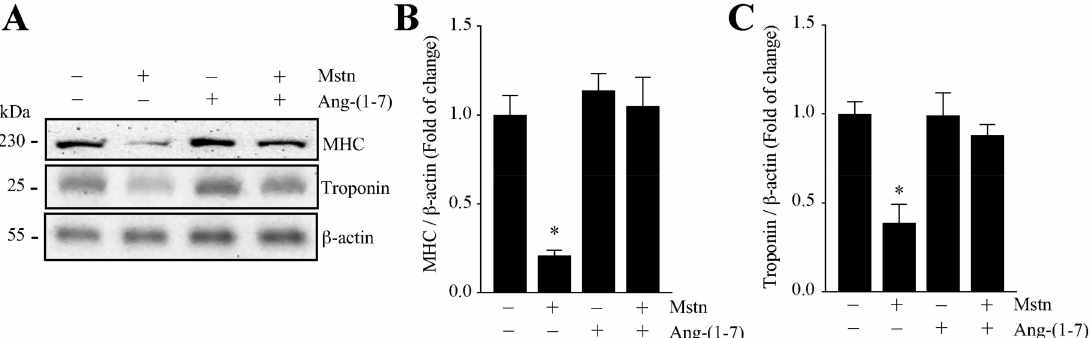
Figure 2. Ang-(1-7) decreased the myostatin-dependent decline in the myofibrillar protein levels in the myotubes. The C 2 C 12 myotubes were incubated with myostatin (Mstn, 1 µ g / mL) for 72 h in the presence or absence of Ang-(1-7) (10 nM; pre-incubated for 1 h). ( A ) The MHC, troponin, and β -actin protein levels were determined by Western blot analysis. The molecular weights are shown in kDa. Densitometric analysis for the MHC ( B ) and troponin ( C ) protein levels with values normalized to β -actin and expressed as a fold of change relative to the control (myotubes without treatment). All of the values correspond to the mean ± SD from three independent experiments ( n = 3; * p < 0.05 vs. control without